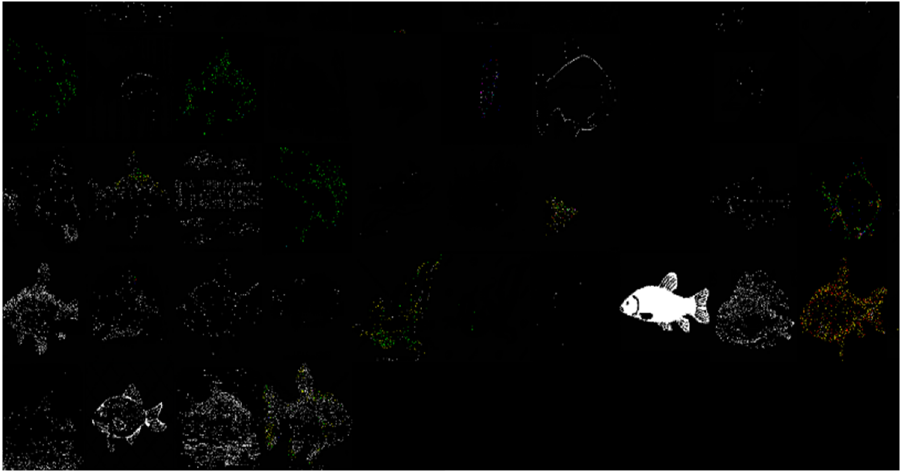
Figure 32. Retrieved images based on features extracted by MobileNetV2 from training using ImageNet-Sketch dataset [42].